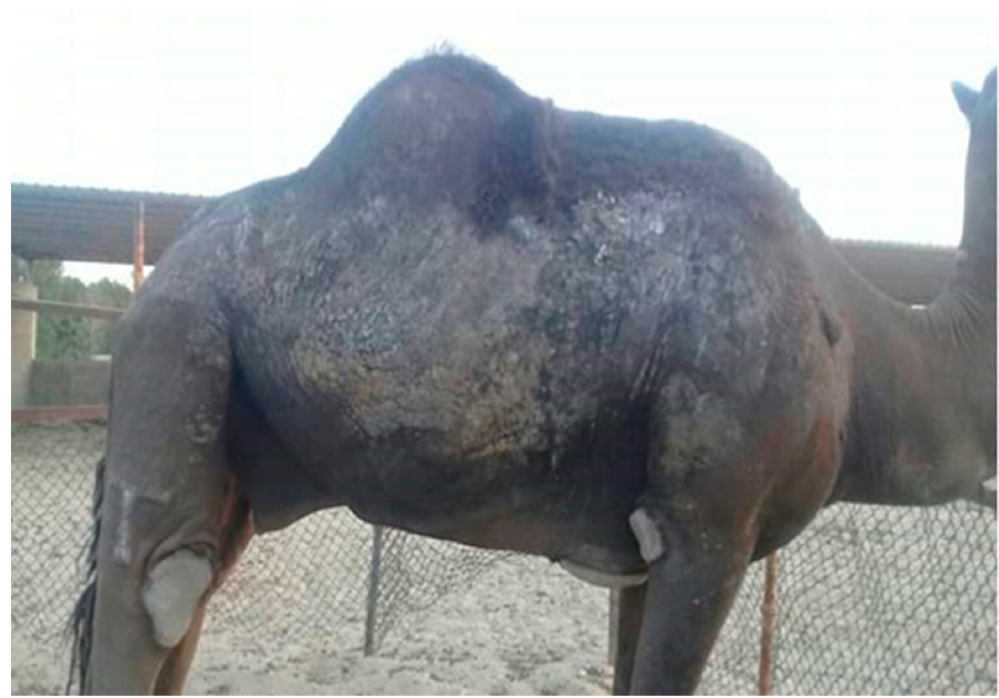
Figure 1. A camel showing some clinical manifestations of sarcoptic mange that includes multiple clinical signs, including thickening and corrugation of the skin, scab formation, pruritic dermatitis and hair loss.